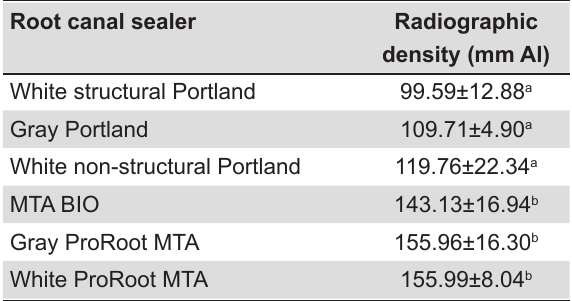
Figure 3- Radiopacity of cements in comparison with steps of the aluminium scale. The black color relates to cements whose radiopacity density (mm Al) fulfills the ANSI-ADA specification number 57 (step 3). The white color refers to cements with radiopacity lower than the value recommended by the Table 1- Radiographic density of the cements (mean ± standard deviation)